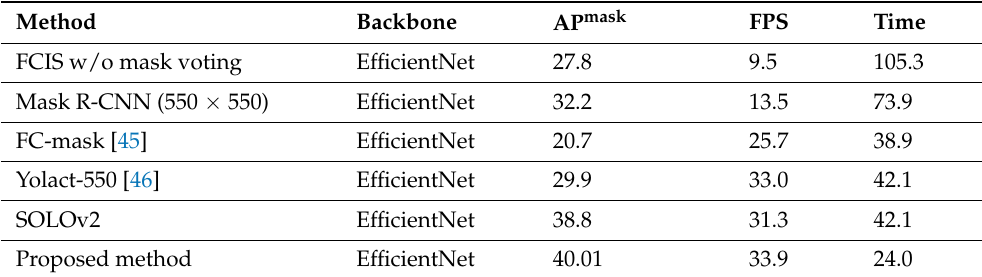
Table 2. Comparison of speed and accuracy with other